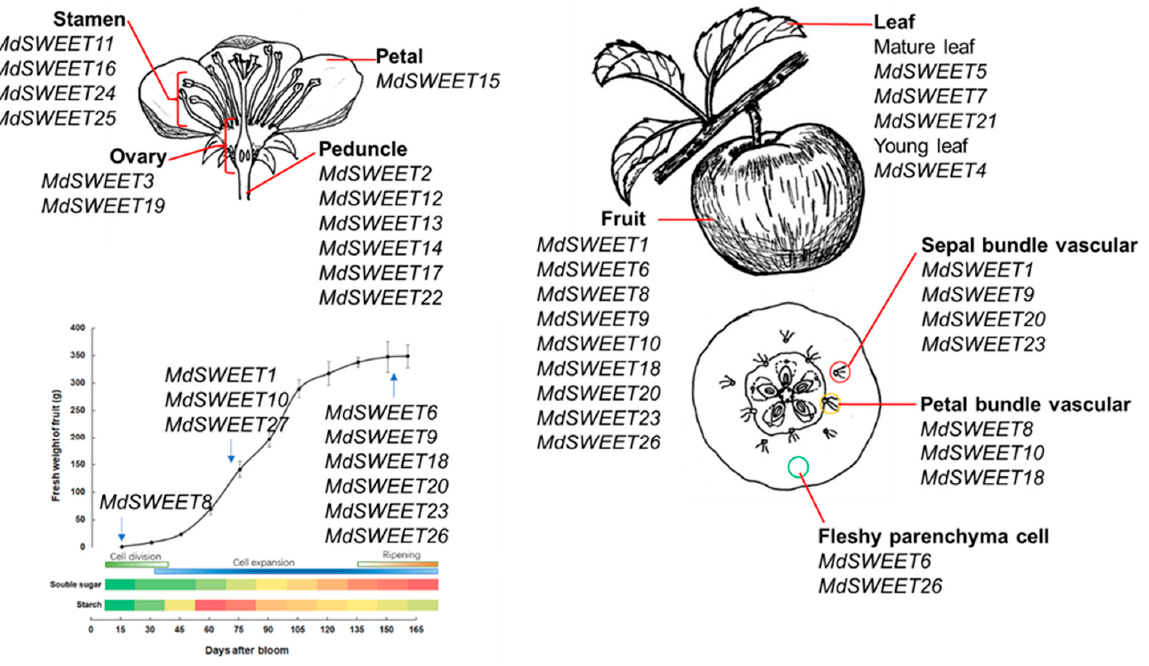
Figure 10. Schematic models of gene expression and roles of MdSWEET proteins in different apple